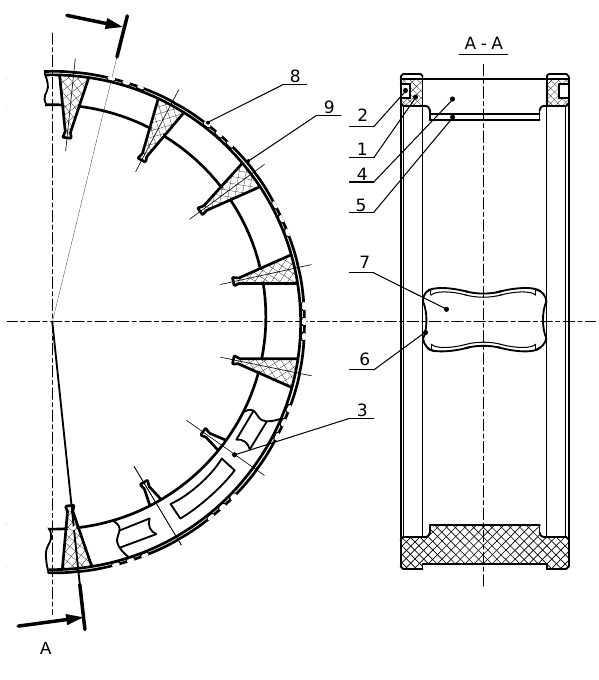
Figure 3. Modernized cage.